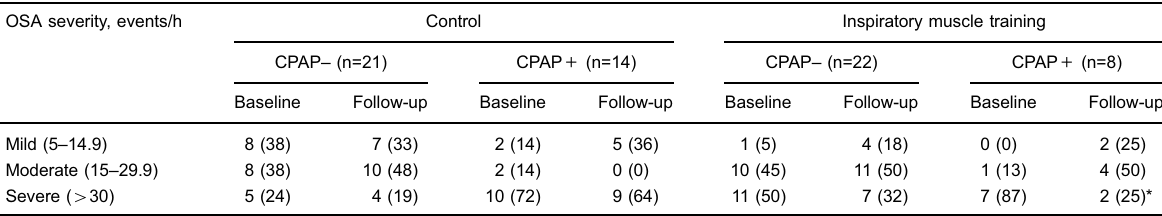
Data are reported as n (%). *P o 0.05 vs baseline of the same subgroup. OSA: obstructive sleep apnea; CPAP( + / – ): with or without continuous positive airway signi fi cant reduction in the ESS was identi fi ed in CPAP